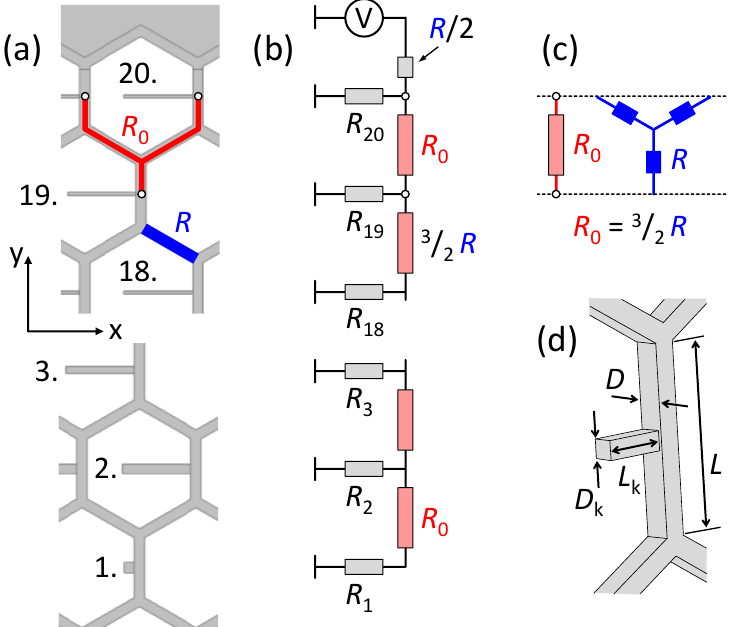
Figure 3. Tubular structure of the stent and fluid resistance model. ( a ) The honeycomb meshwork geometry is the same everywhere; only the outlet tubes have different dimensions. The star-shaped part, colored in red, can be expressed as a fluidic resistance R 0 between two subsequent outlet tubes. ( b ) Equivalent circuit diagram of a single column of the stent, from the fluid inlet (top) to the individual outlets. The numbered resistors R 1 to R 20 correspond to the various outlet tubes along the stent column. Due to the different dimensions, the outlet tubes have distinct flow resistances. The dimensions are chosen so that the same rate of liquid flows out of each tube. The diagram in ( c ) illustrates how the resistance R 0 can be calculated using the flow resistance R of a straight channel segment (marked in blue). Drawing ( d ) depicts the relevant geometric entities for the calculation of the flow resistance.